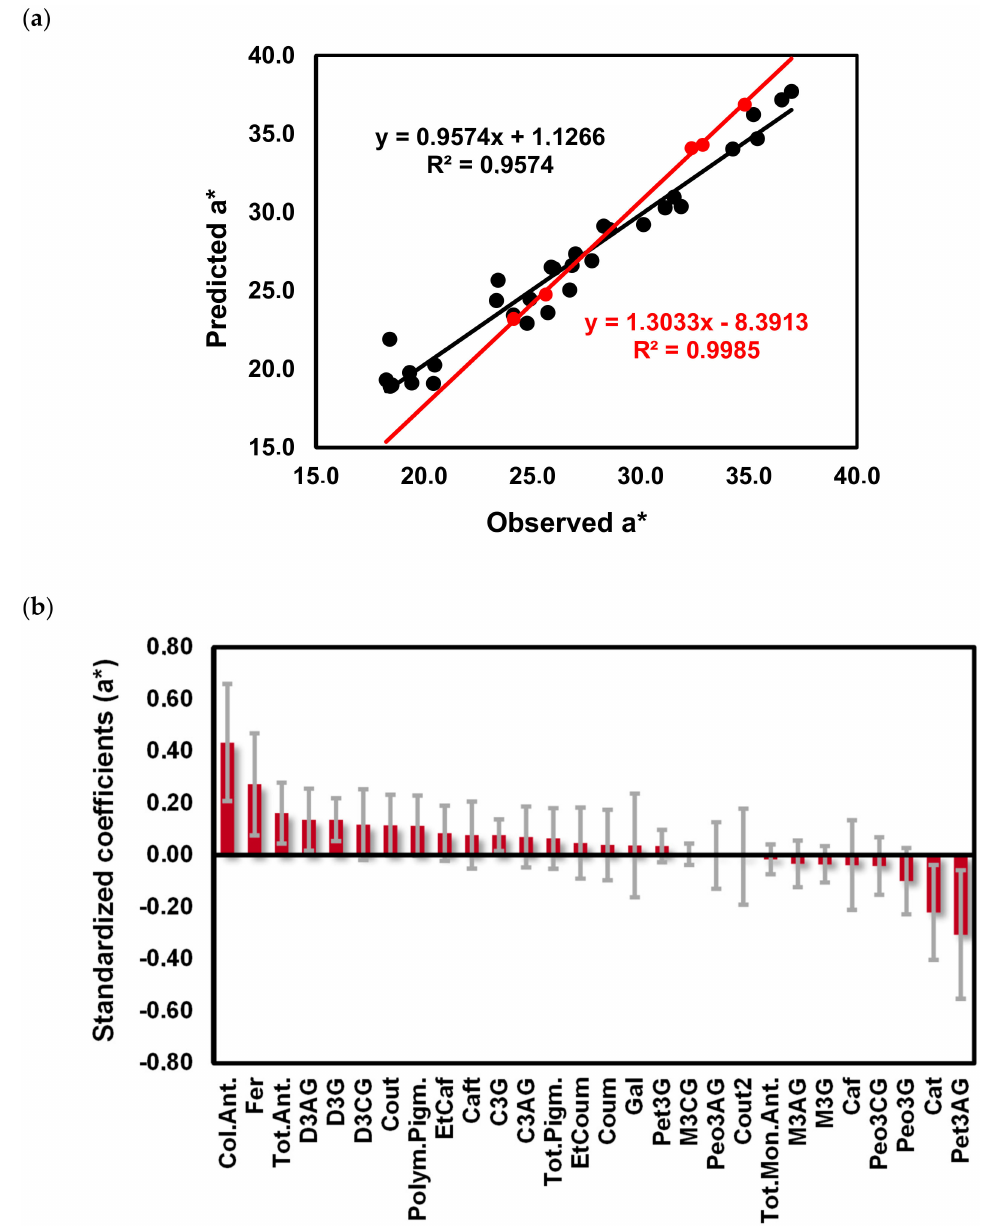
Figure 9. Calibration curves obtained after PLS regression of the a* values of ‘Menc í a’ / ‘Jaen’ wines using the phenolic composition and colorimetric determination of colored anthocyanins (Col.Ant.), polymeric pigments (Polym.Pigm.), total pigments (Tot.Pigm.), total anthocyanins (Tot.Ant.) as independent variables (black circles calibration samples, red circles test samples) ( a ) and B coe ffi cients plots ( b ). Delphinidin-3-glucoside (D3G), cyanidin-3-glucoside (C3G), peonidin-3-glucoside (Peo3G), petunidin-3-glucoside (Pet3G), malvidin-3-glucoside (M3G), delphinidin-3-acetylglucoside (D3AG), cyanidin-3-acetylglucoside (C3AG), peonidin-3-acetylglucoside (Peo3AG), petunidin-3-acetylglucoside (Pet3AG), malvidin-3-acetylglucoside (M3AG), delphinidin-3-coumaroylglucoside (D3CG), peonidin-3-coumaroylglucoside (Peo3CG), malvidin-3-coumaroylglucoside (M3CG), gallic acid (Gal), caftaric acid (Caft), coutaric acid (Cout), coutaric acid isomer (Cout2), ca ff eic acid (Caf), coumaric acid (Coum), catechin (Cat), ethyl ester of ca ff eic acid (EtCaf), ethyl ester of coumaric acid (EtCoum), total monomeric anthocyanins (Tot.Mon.Ant.), total pigment (Tot.Pigm.), polymeric pigments (Polym.Pigm.), colored anthocyanins (Col.Ant.), total anthocyanins measured colorimetrically